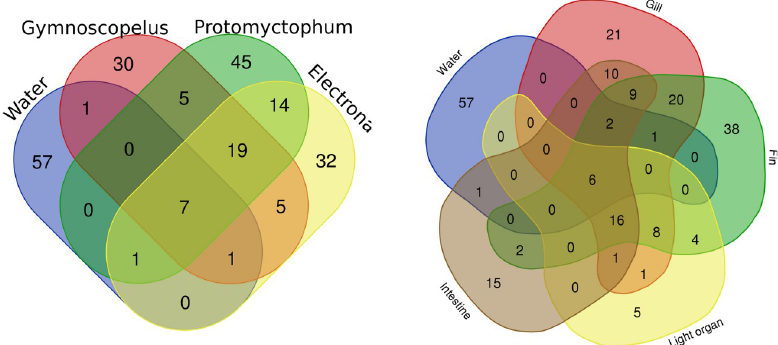
Fig 3. Venn diagrams displaying the number of shared ASVs among the myctophid genera (left) and organs (right). Only ASVs representing at least 1% of reads in at least one sample are included.